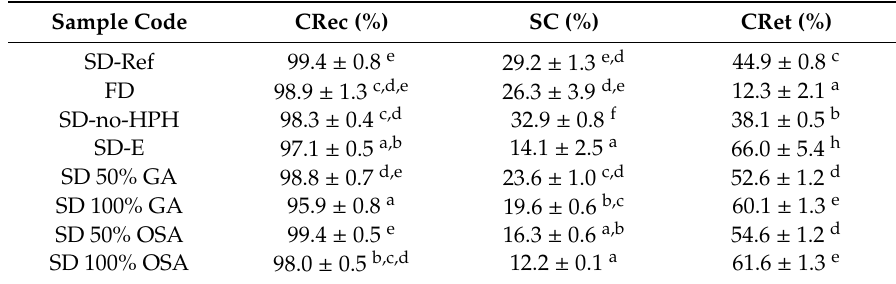
Table 2. Carotenoid recovery (CRec), surface carotenoid (SC) content after production, and carotenoid retention (CRet) after 91 days storage (35 °C, air) of carrot concentrate powders produced without added antioxidants.